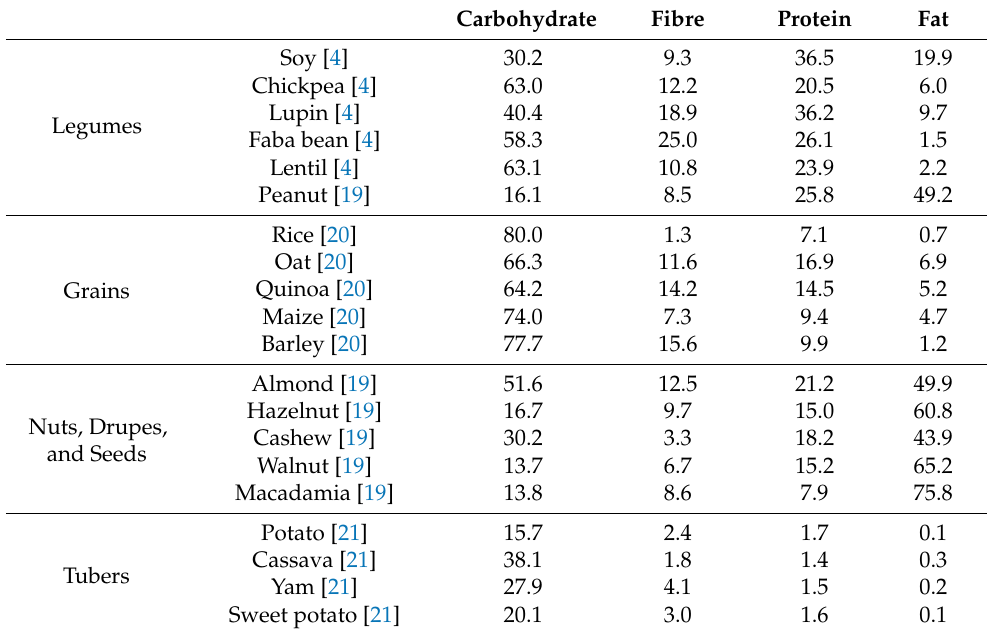
Table 1. Carbohydrate, fibre, total protein, and total fat content of some common plant-based raw materials (all values are expressed in g/100 g dry